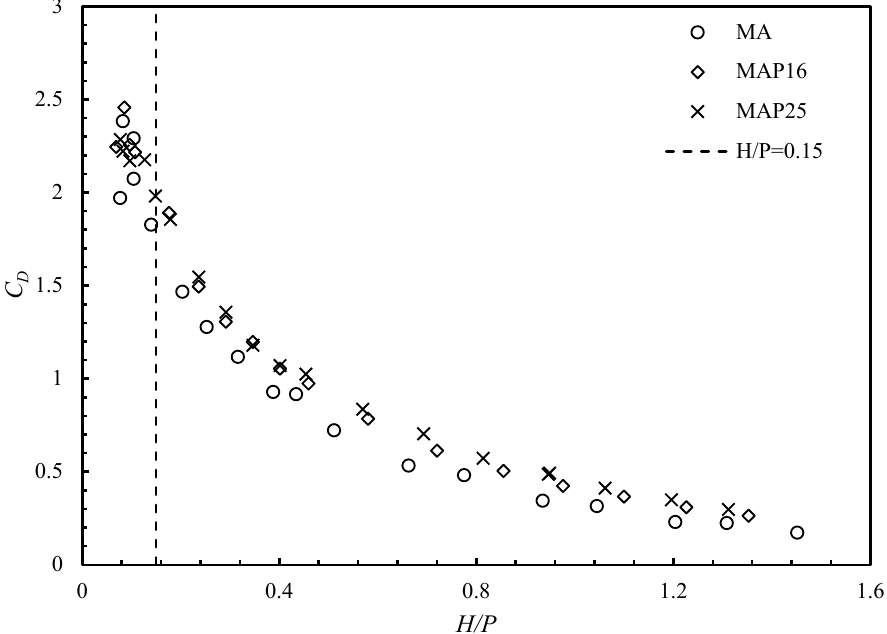
Figure 8. Variation of C D with H/P ratio for models M A , M AP 16 , and M AP 25 .